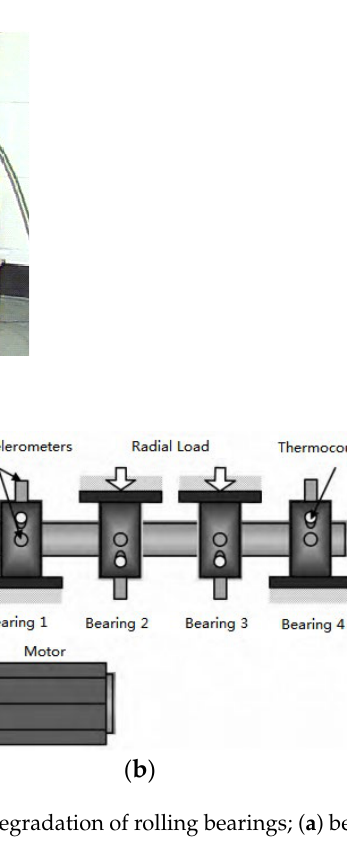
Figure 5. The experimental equipment of the state degradation of rolling bearings; ( a ) bearing test rig illustration; ( b ) sensor placement in the test rig [34].